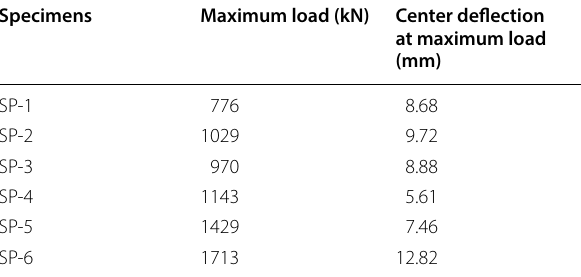
Table 4 Maximum load and center deflection of test